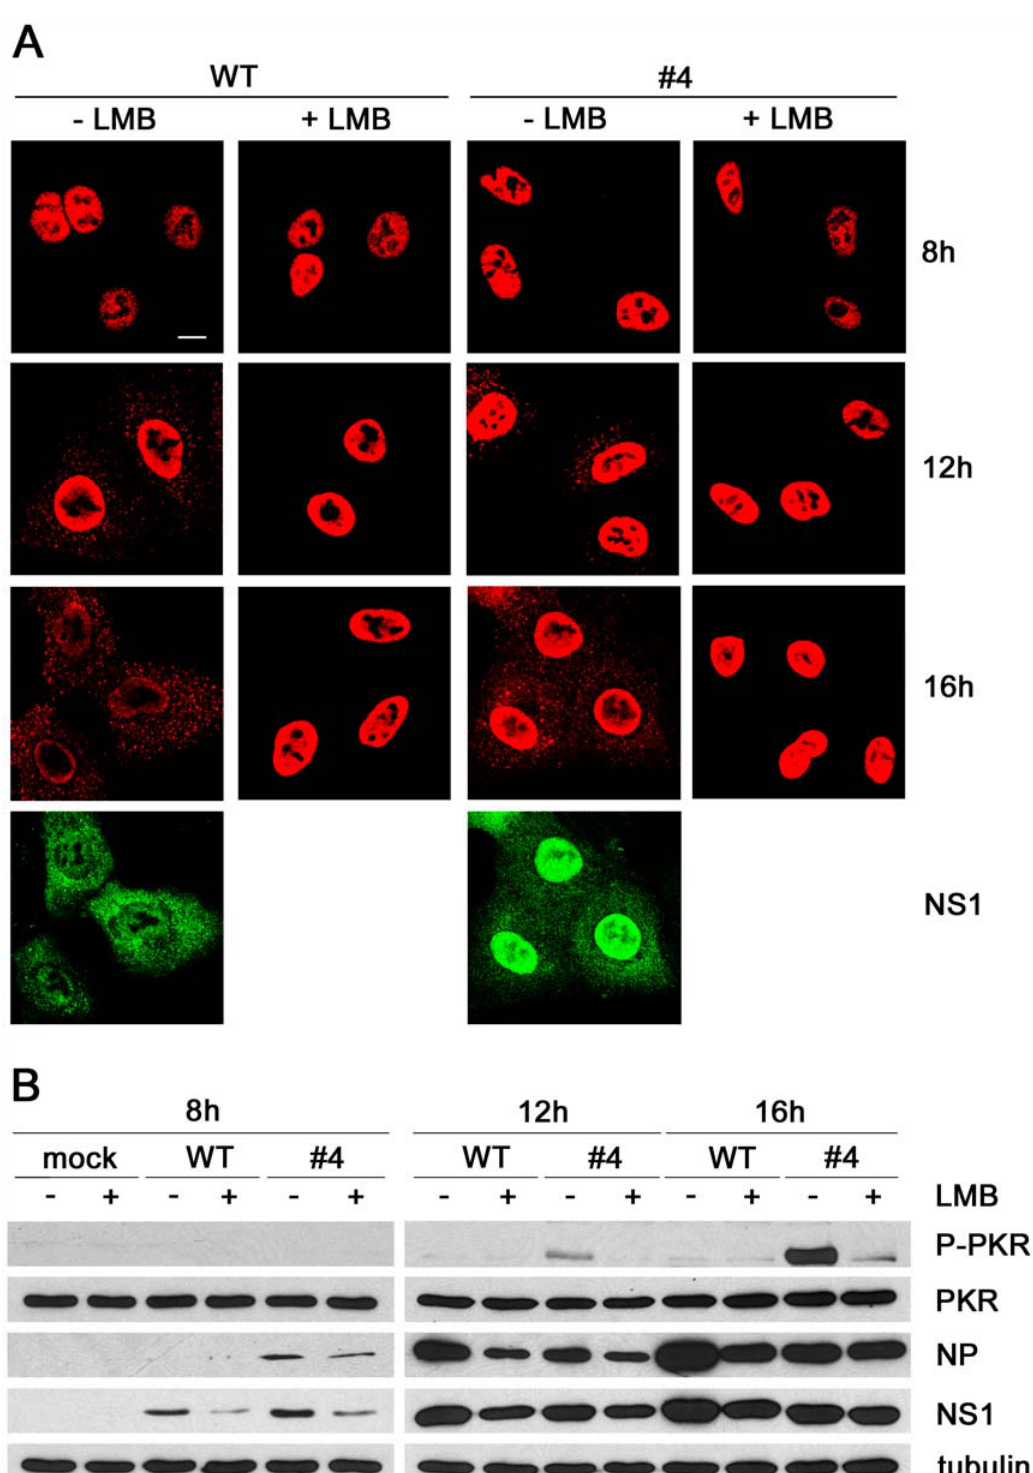
Figure 4. The nuclear egress of vRNPs late in infection leads to PKR activation. (A) A549 cells grown on glass cover slips were infected with WT or mutant virus # 4 at an MOI of 1. Cells were mock treated or complemented with LMB starting at 3 hours p.i.. At 8, 12 and 16 hours p.i., cells were fixed and stained for NP (shown in red color), and also for the NS1 protein at the 16 h time-point (shown in green color). Microscopic sample analysis was conducted by confocal laser scanning microscopy. Scale bar, 10 m m. (B) A549 cells grown in culture dishes were infected with WT virus or mutant virus # 4 at an MOI of 1. Cells were mock treated or complemented with LMB starting 3 hours p.i. and lyzed 8, 12 and 16 hours p.i.. Whole cell lysates were analyzed by immunoblotting with antibodies specific for phospho-PKR, total PKR, NP, NS1 and tubulin as indicated.